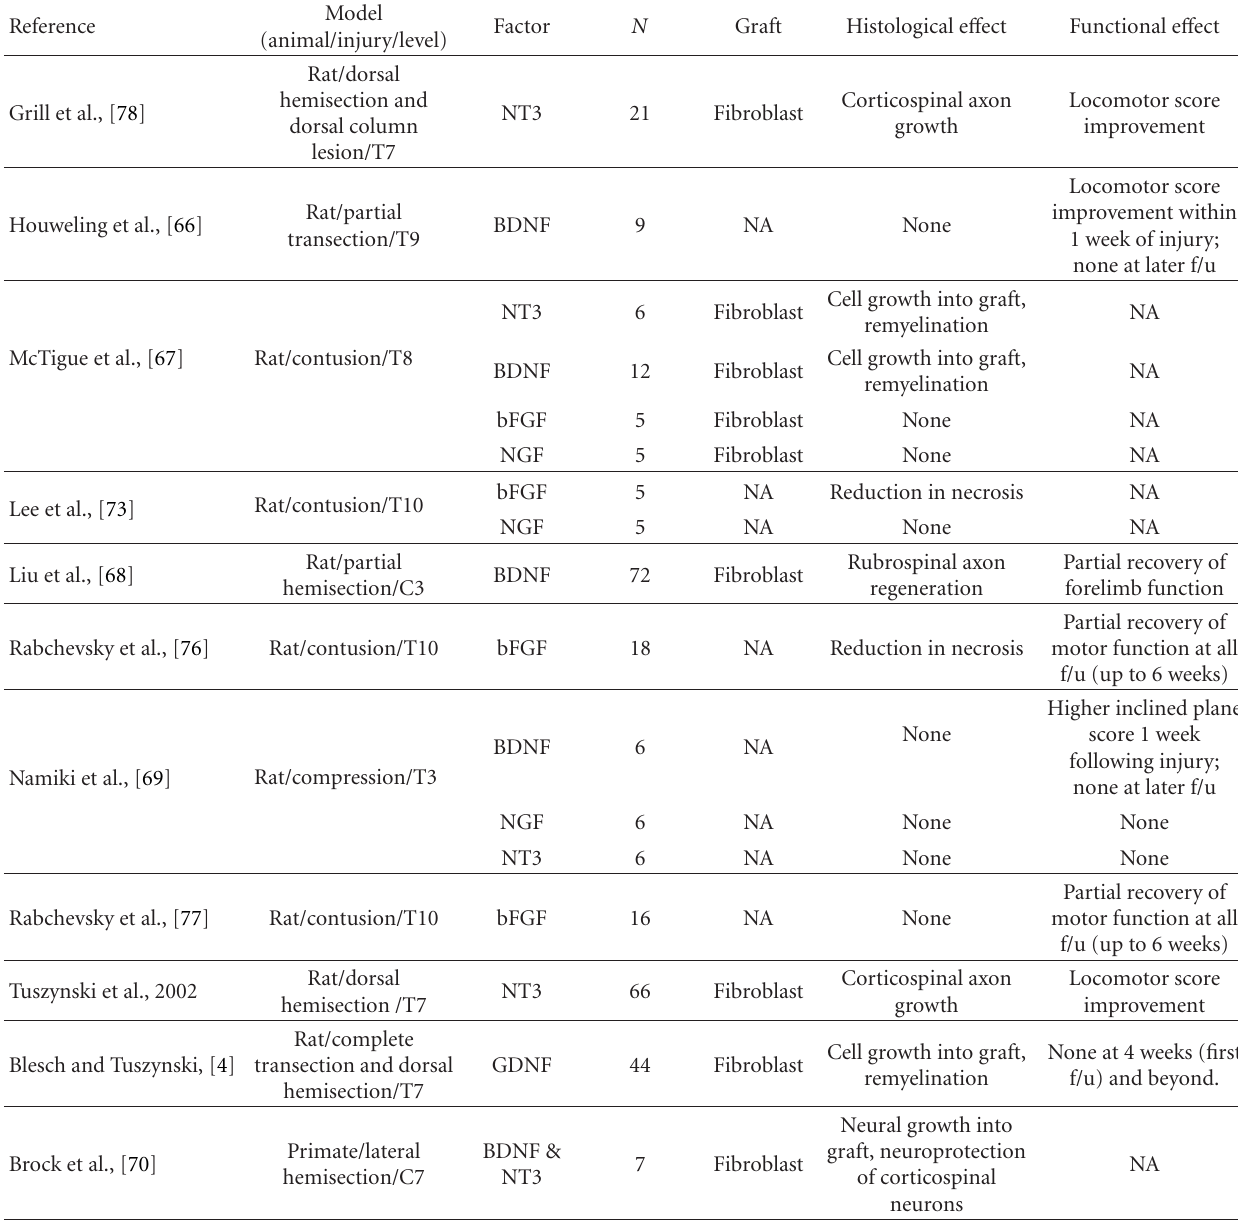
Table 1: A review of the published studies on growth factors and spinal cord